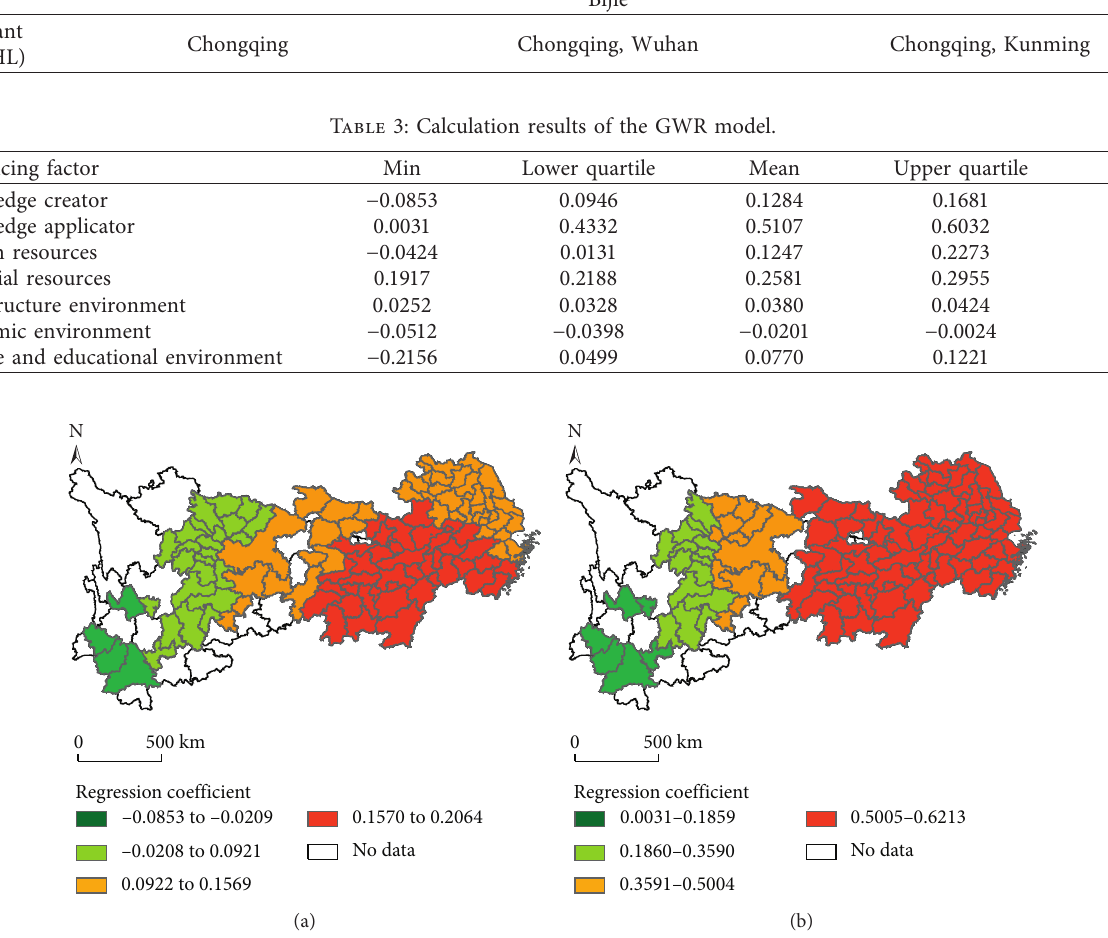
Figure 4: Spatial distribution of regression coefficient of innovation subject to innovation output. (a) Universities and research institutes. (b)